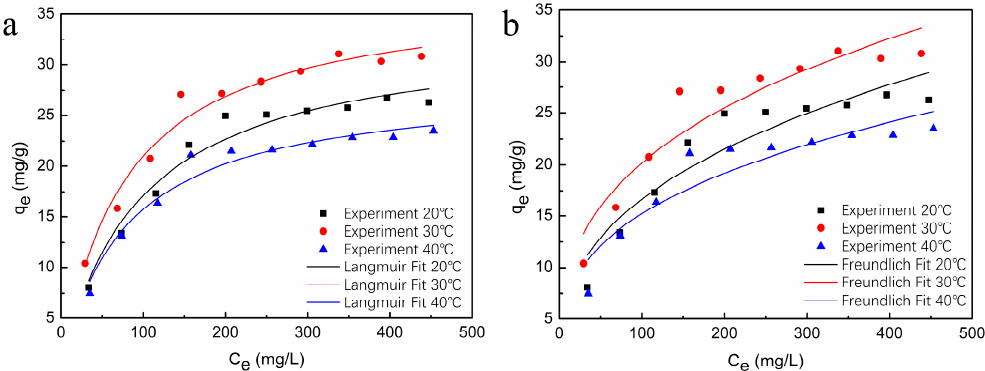
Figure 7. Adsorption equilibrium with different initial phenol concentrations and ( a ) Langmuir isotherm model fitting curves, and ( b ) Freundlich isotherm model fitting curves.